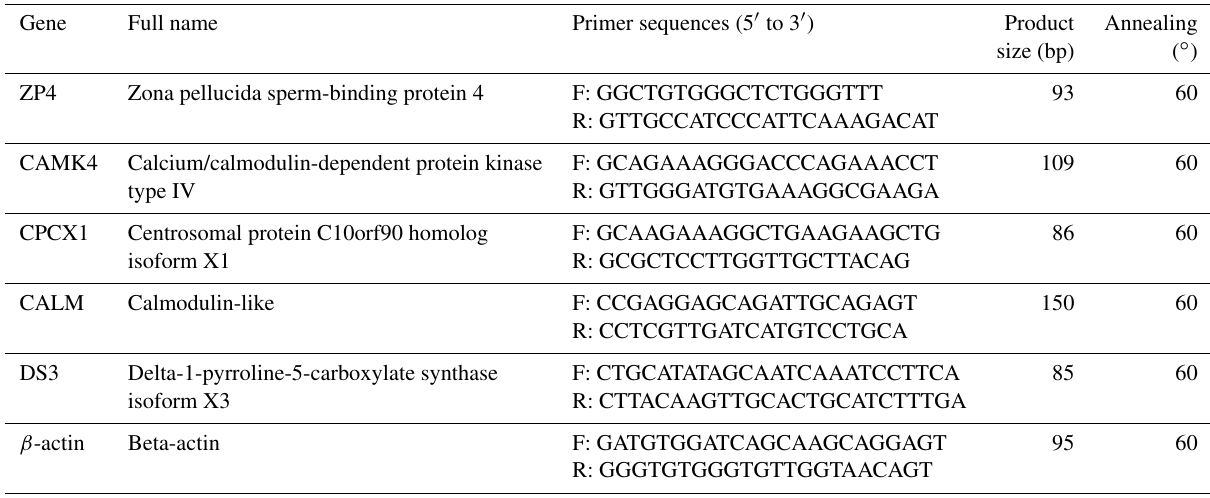
Table 1. Primer information for qRT-PCR.